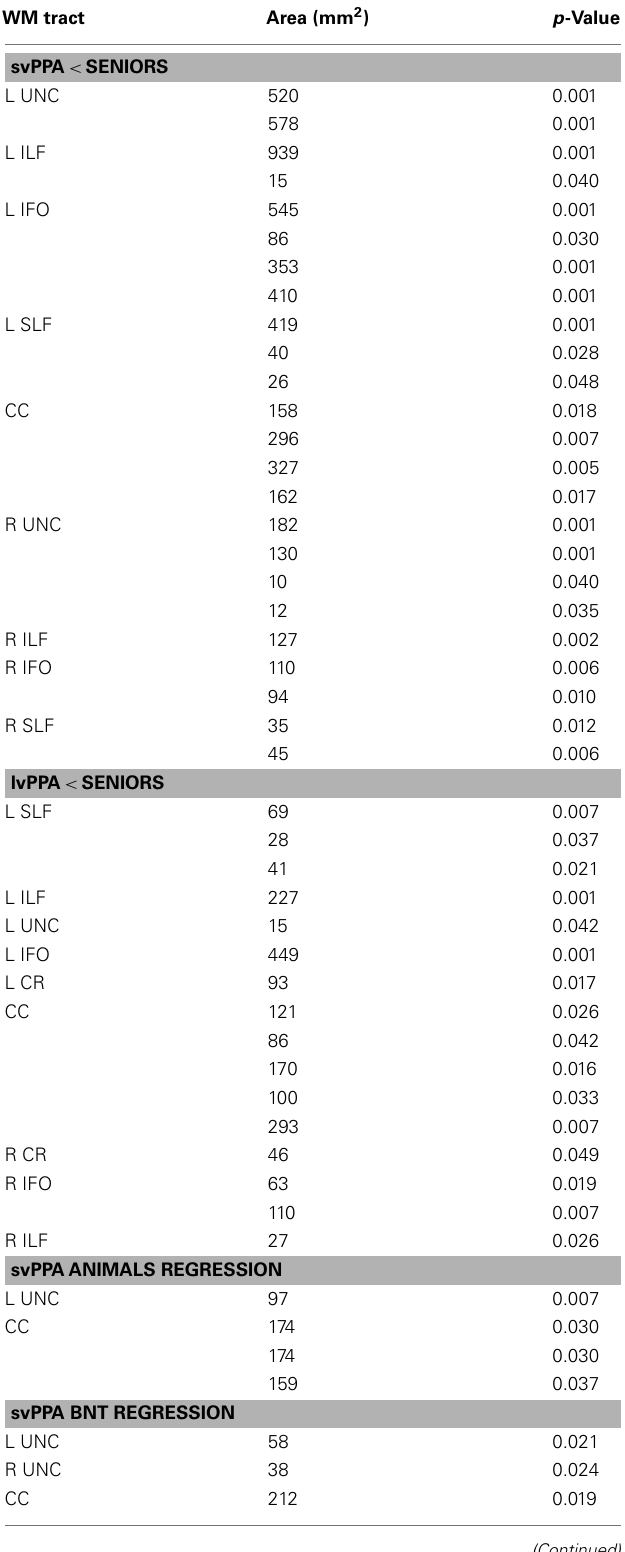
Table 2 | Clusters of reduced fractional anisotropy and regressions relating fractional anisotropy to language